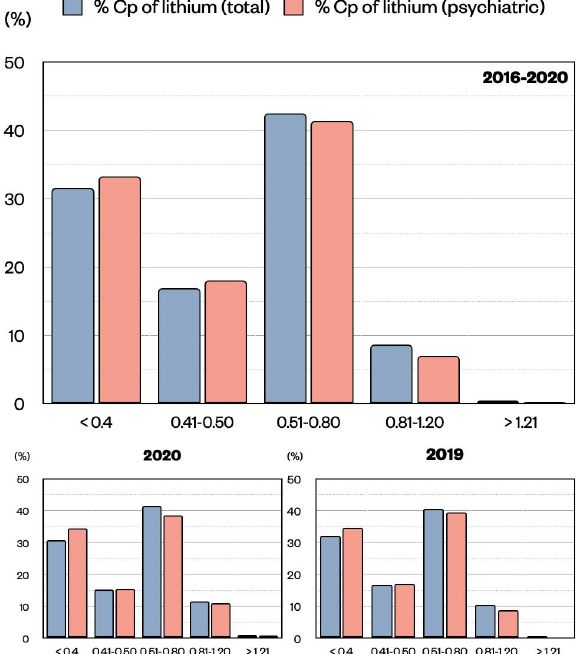
Figure 2. Distribution of lithium Cp (mmol/L) expressed as percentage of the total population (pink) or of the psychiatric unit only (blue) divided by ranges (<0.4, 0.41 – 0.50, 0.51 – 0.80, 0.81 – 1.20, >1.20). Data are shown for all five years 2016 – 2020, and for the single years 2020 and 2019, respectively. No significant difference was observed in the distribution of Cp samples in the two populations by means of z-test.